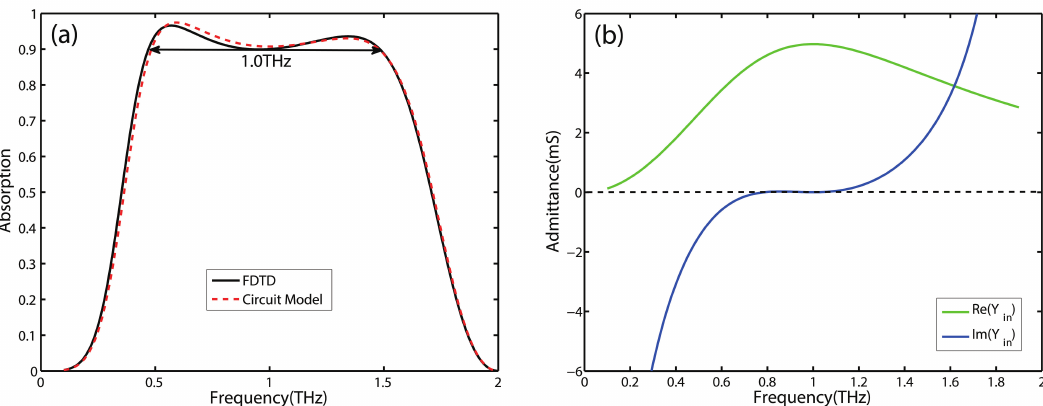
Figure 5. ( a ) The absorption spectrum of the designed broadband absorber with the central frequency at 1 THz simulated by FDTD simulations and calculated by circuit model. ( b ) Real and imaginary parts of the input admittance of the designed absorber.